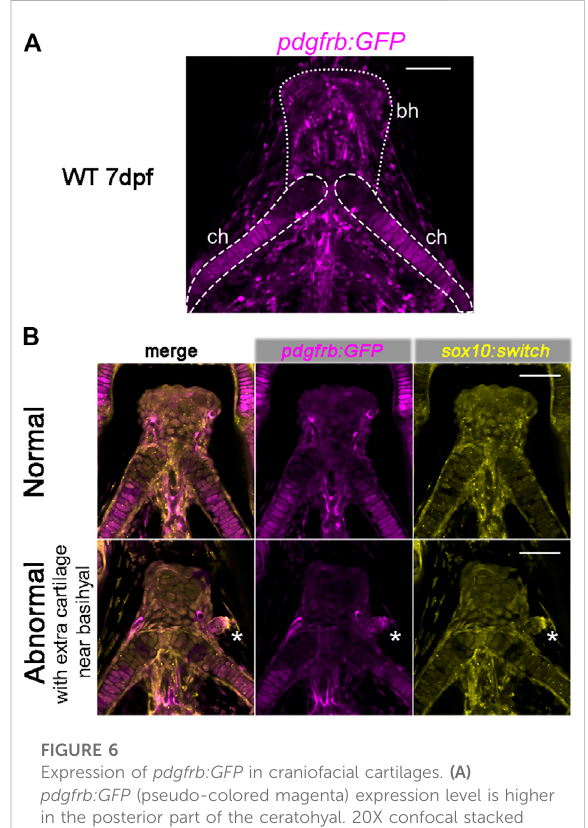
FIGURE 6 Expression of pdgfrb:GFP in craniofacial cartilages. (A) pdgfrb:GFP (pseudo-colored magenta) expression level is higher in the posterior part of the ceratohyal. 20X confocal stacked images, number of stacks n = 7, interval = 12 µm. (B) Representative images for the normal and abnormal basihyal in chd7 sr5 mutant fi sh. The abnormal one has extra cartilage near the basihyal cartilage, which expressesmore pdgfrb:GFP compared to the basihyal cartilage and the nearby ceratohyal. sox10:switch (pseudo-colored yellow) labels NCCs. The white asterisks mark the extra cartilage. 20X single-slice confocal image. ch: ceratohyal; bh: basihyal (the number of fi sh with extra cartilage: WT:0in6, chd7 +/sr5 :1in13,and chd7 sr5 :4in14).Scalebar=50 µm for all